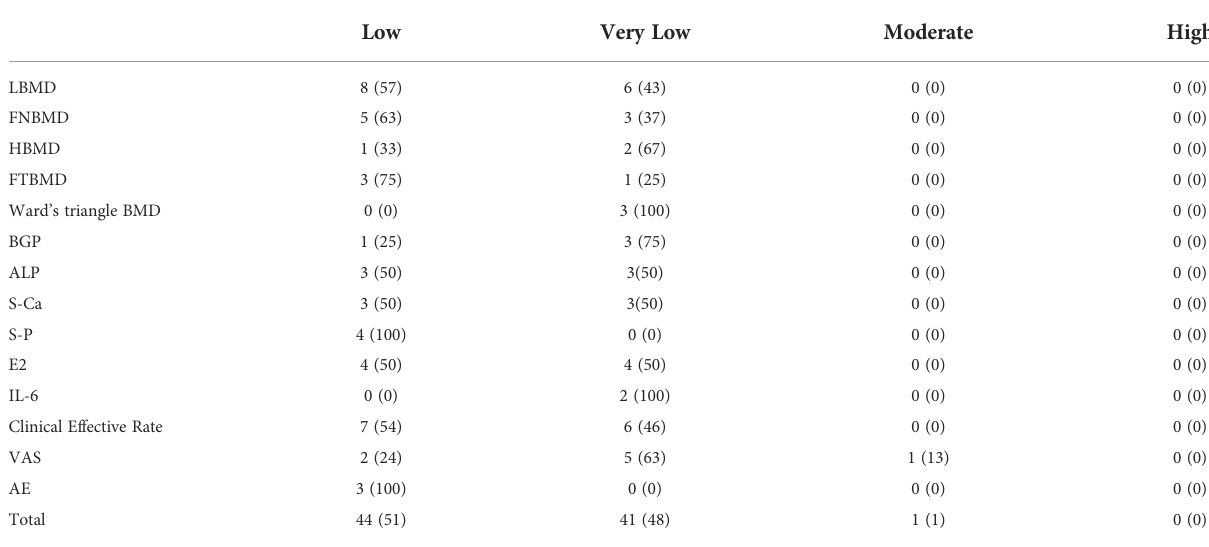
TABLE 4 Quality of Evidence in the included systematic reviews or Meta-analysis.